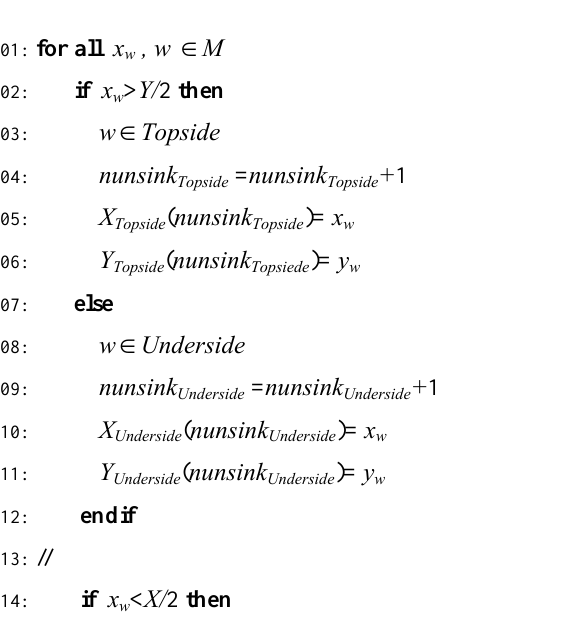
Algorithm 1 : sink w pre-decide its coarse